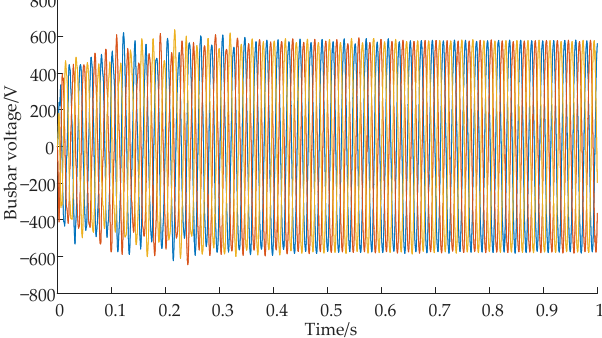
Figure 12. The root locus of D (s) following m 1 changes when m 2 = 2.5 × 10 − 5 Hz/W. The locus is so similar to Figure 8 that it won’t be described again. The proper range of m 1 is [0, 7.21 × 10 − 5 ), and system stability declines with the increase of m 1 . When m 1 = 5 × 10 − 5 Hz/W and m 2 = 2.5 × 10 − 5 Hz/W, the bus voltage waveform is shown in Figure 13. The waveform is similar to Figure 9, without more detailed analysis. Time/s B u s b a r v o l t a g e / V